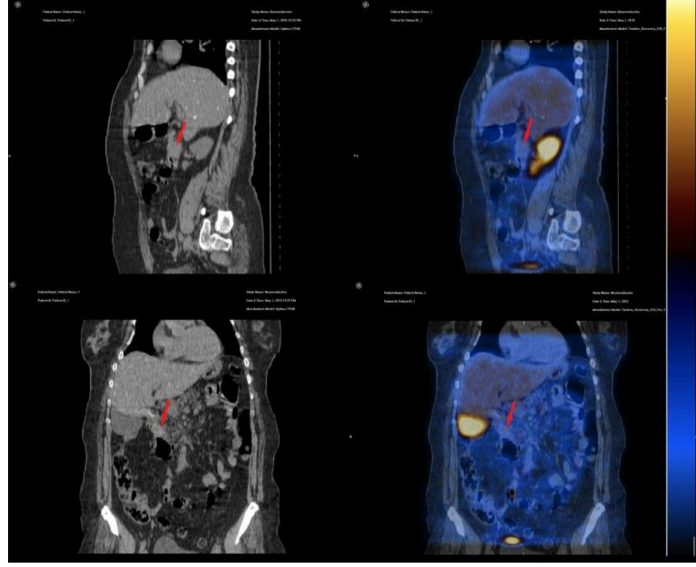
Figure 11. Sagital and coronal CT and SPECT-CT acquisition; duodenal tumor without 99mTc-EDDA / HYNIC-Tyr3-Octreotide uptake, suggesting no expression of SSTR2 or SSTR5 (red